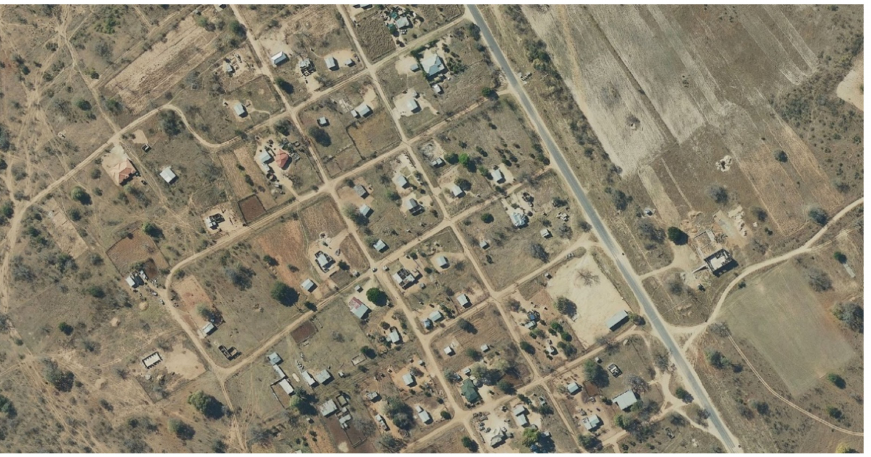
Figure 1. Extract from 2018 rectified imagery [12], (Ref: 2531 AC 10), showing part of a rural village known as Buyelani on communal land in the Mpumalanga Province, at scale: 1:5000